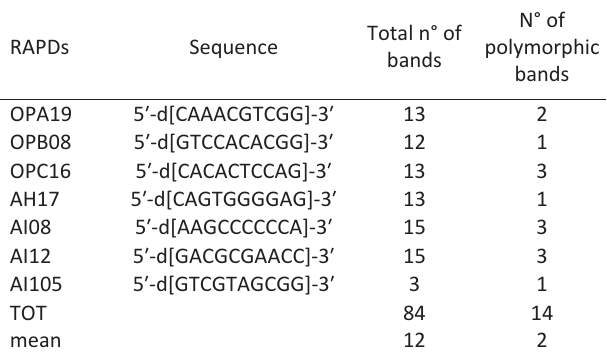
Table 4 ­ Primer sequence of the most informative primers and level of polymorphism found by the RAPD analysis